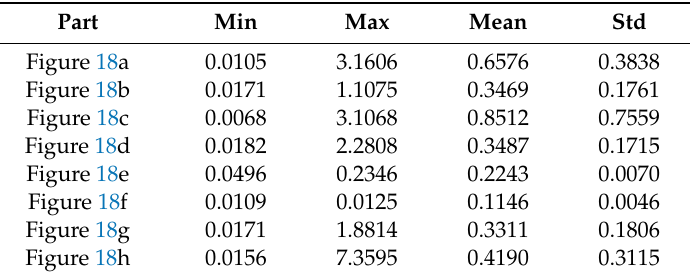
Table 4. Inspection results (mm). Figure